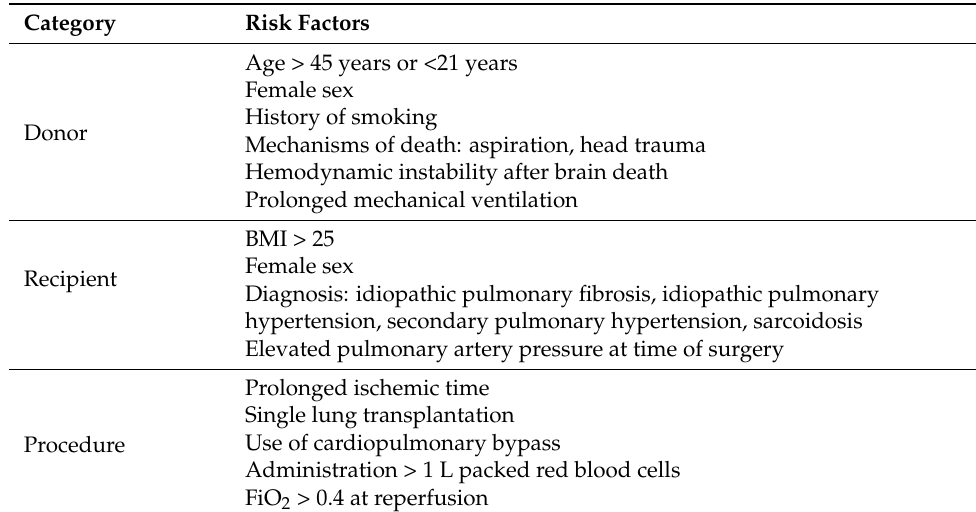
Figure 1. Two phenotypes of PGD grade 3 after LTx with serial chest X-rays (CXR) from two LTx recipients taken at time-point T0/24/48/72 after reperfusion of the second lung. ( A ) CXRs visualizing the phenotype with early transient PGD grade 3. The patient underwent sequential single-LTx via bilateral anterior thoracotomy for end-stage emphysema without extracorporeal life support (ECLS). ( B ) CXRs visualizing the phenotype with increasing and late PGD grade 3. The patient underwent sequential single-LTx via bilateral anterior thoracotomy for end-stage emphysema without ECLS. P/F = PaO 2 or partial pressure of arterial oxygen/FiO 2 or fraction of inspired oxygen. Table 2. Clinical risk factors for PGD after